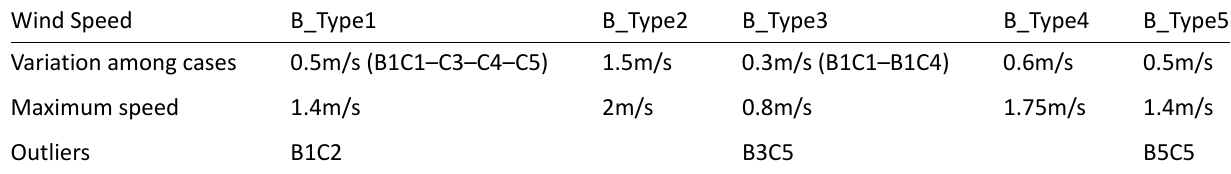
Table 3. Patterns of wind speed per building type.